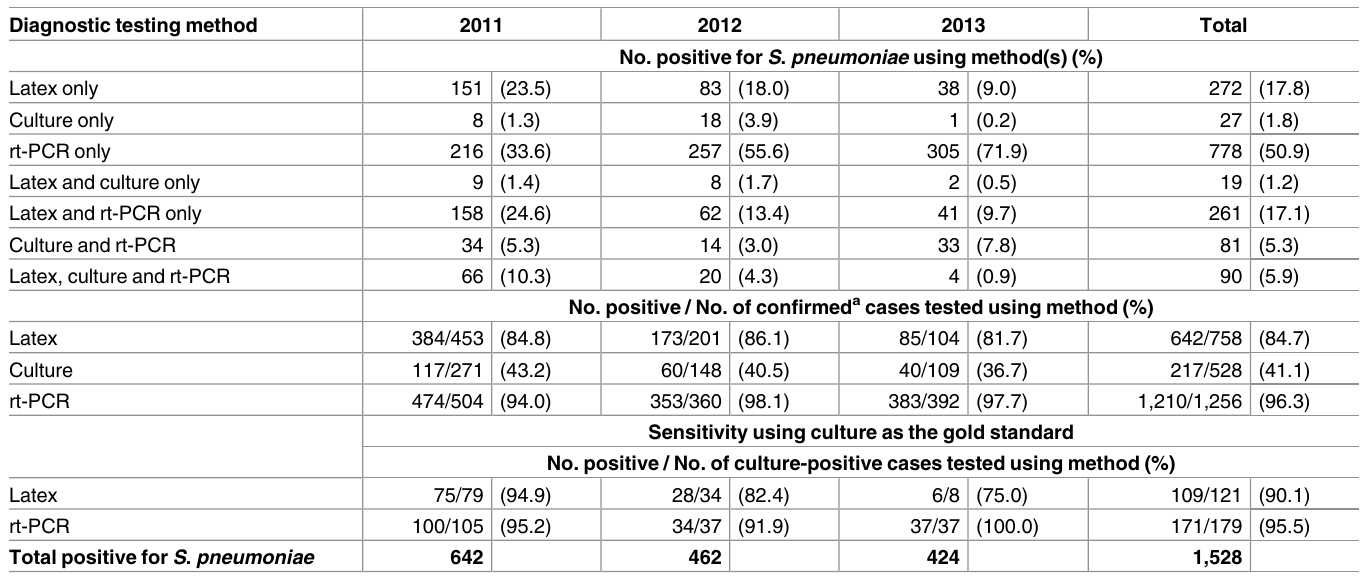
Table 4. S . pneumoniae diagnostic test results among confirmed a pneumococcal meningitis cases, Burkina Faso,